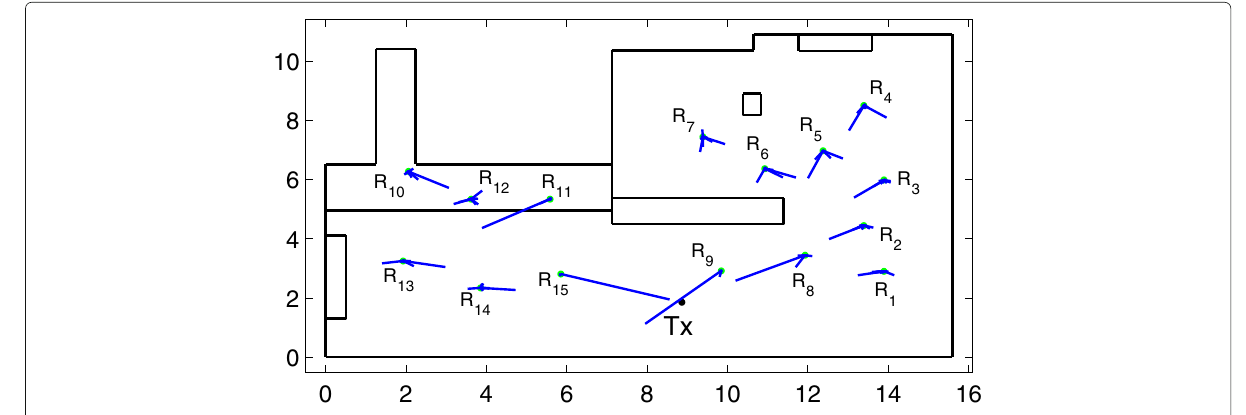
Fig. 15 Estimated geometrical propagation paths in the